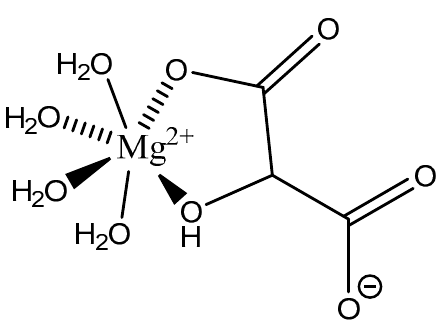
Figure 13. Structure of malic acid.